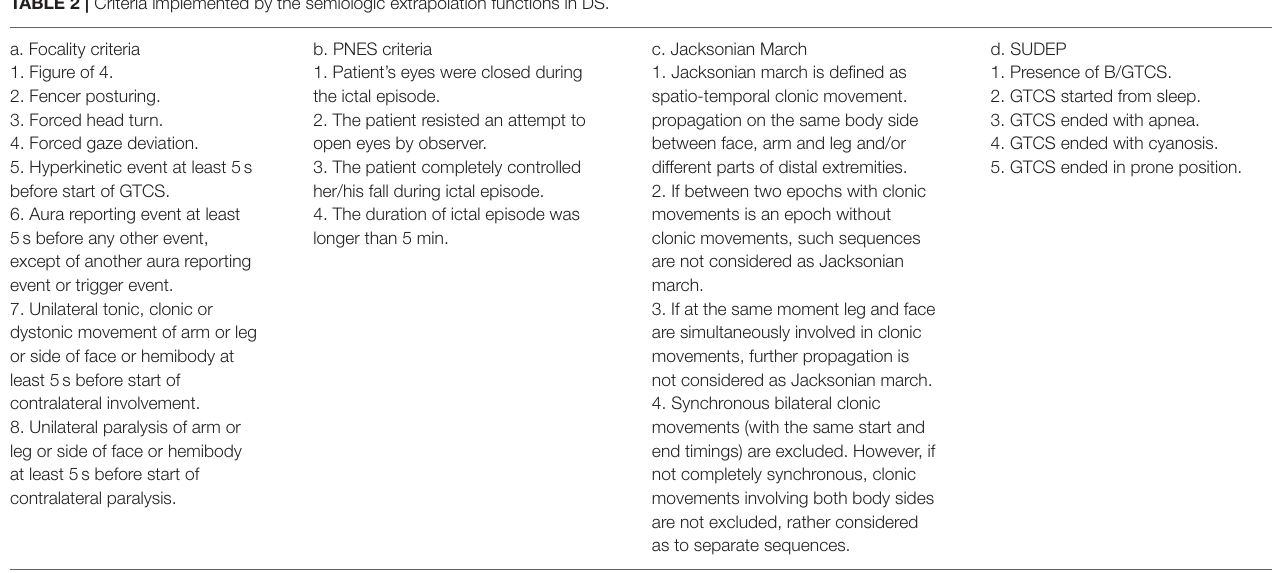
TABLE 2 | Criteria implemented by the semiologic extrapolation functions in DS. a. Focality criteria 1. Figure of